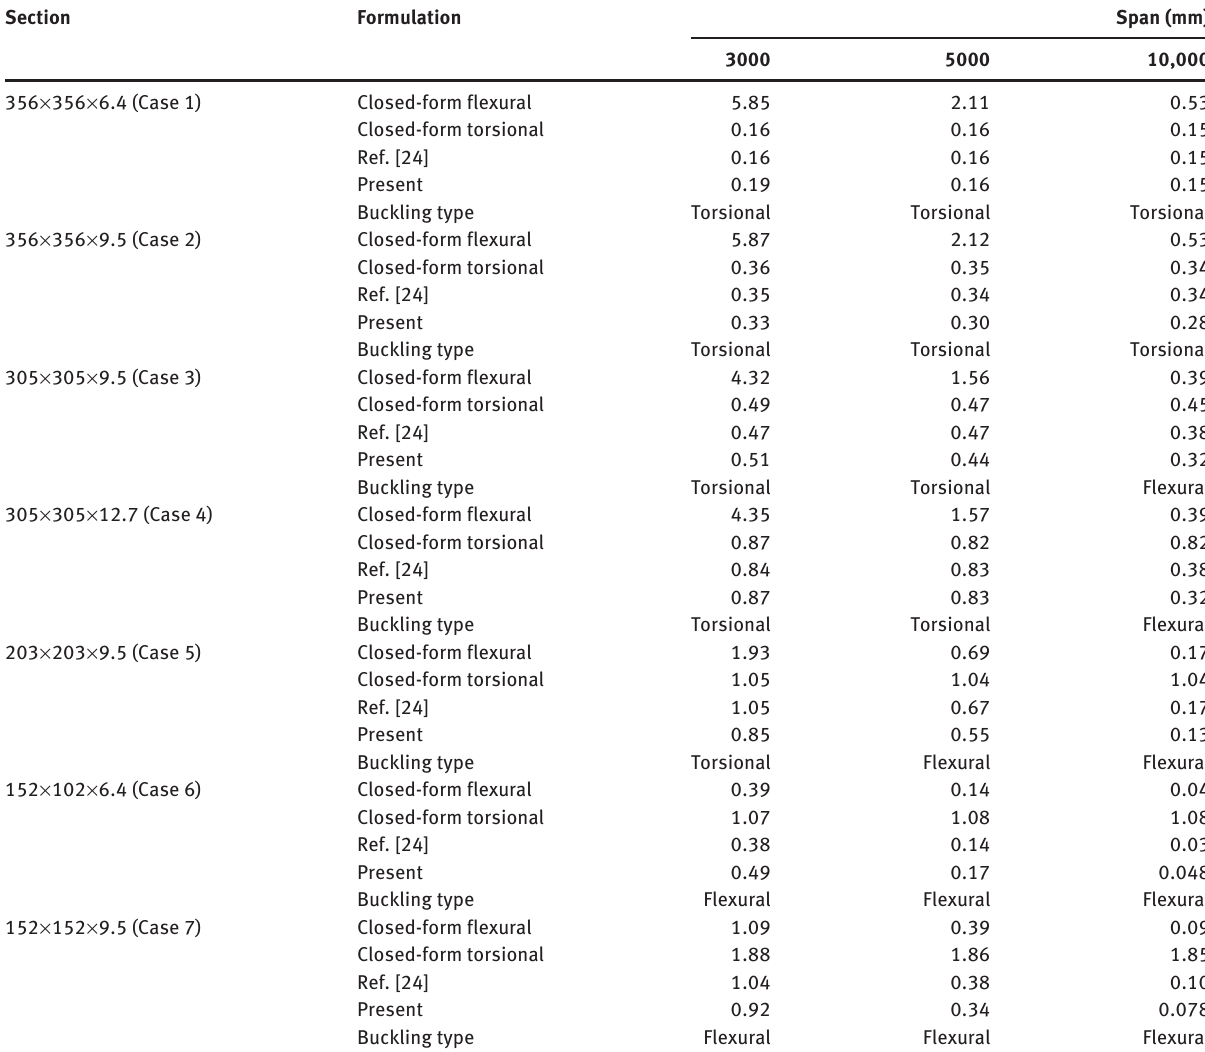
Table 5 Normalized critical buckling stresses of FRP unstiffened cruciform-shaped section